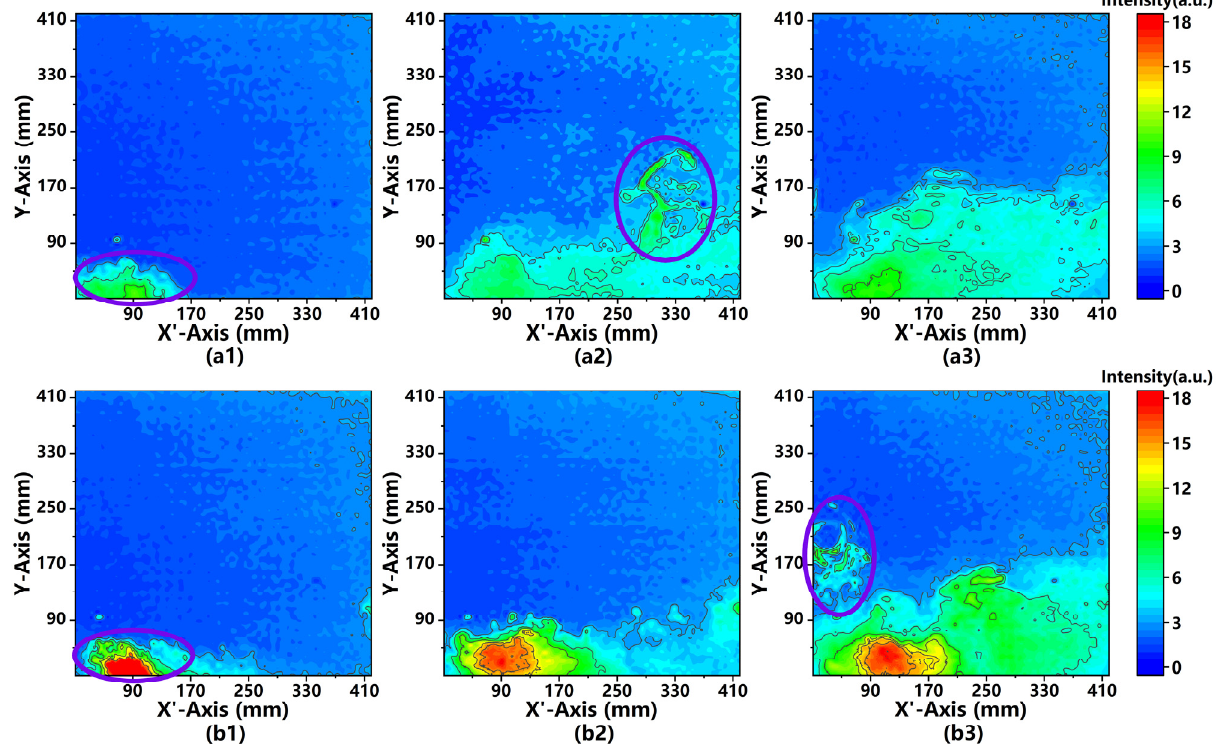
Figure 8. The 2D intensity distribution of PLIF images captured at the 2.5th, 7.5th, and 12.5th second. The concentration of the atomized fluorescein solution in ( a1 ), ( a2 ) and ( a3 ) is 0.05 g/L, and the concentration of the atomized fluorescein solution in ( b1 ), ( b2 ) and ( b3 ) is 0.1 g/L. The signals were obtained with the laser power of 100 mW, a 25 ms frame, and an atomization rate of 0.5 mL/s.